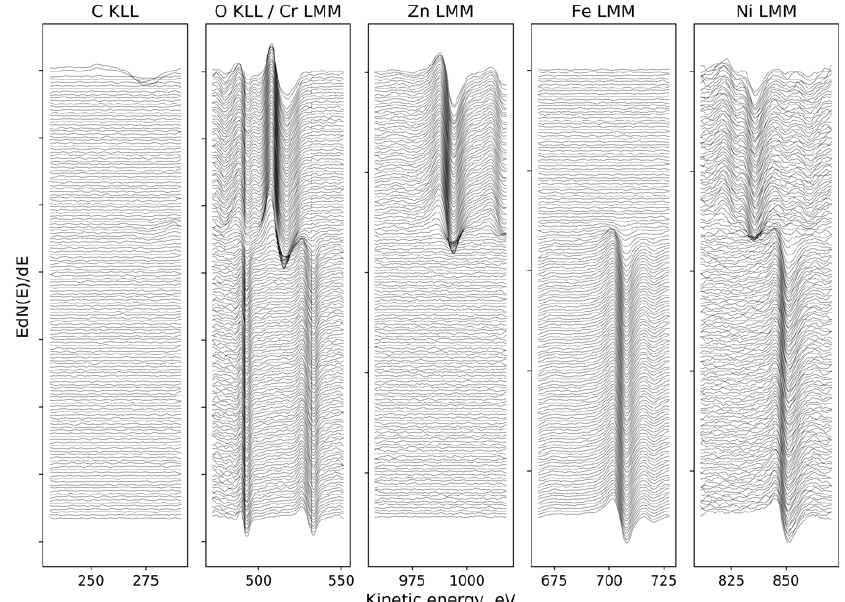
Figure 2. Electropolished 1500_300: the evolution of the spectral lines for the major element, registered between ion etching cycles, ordered from surface (top) to the substrate (bottom).